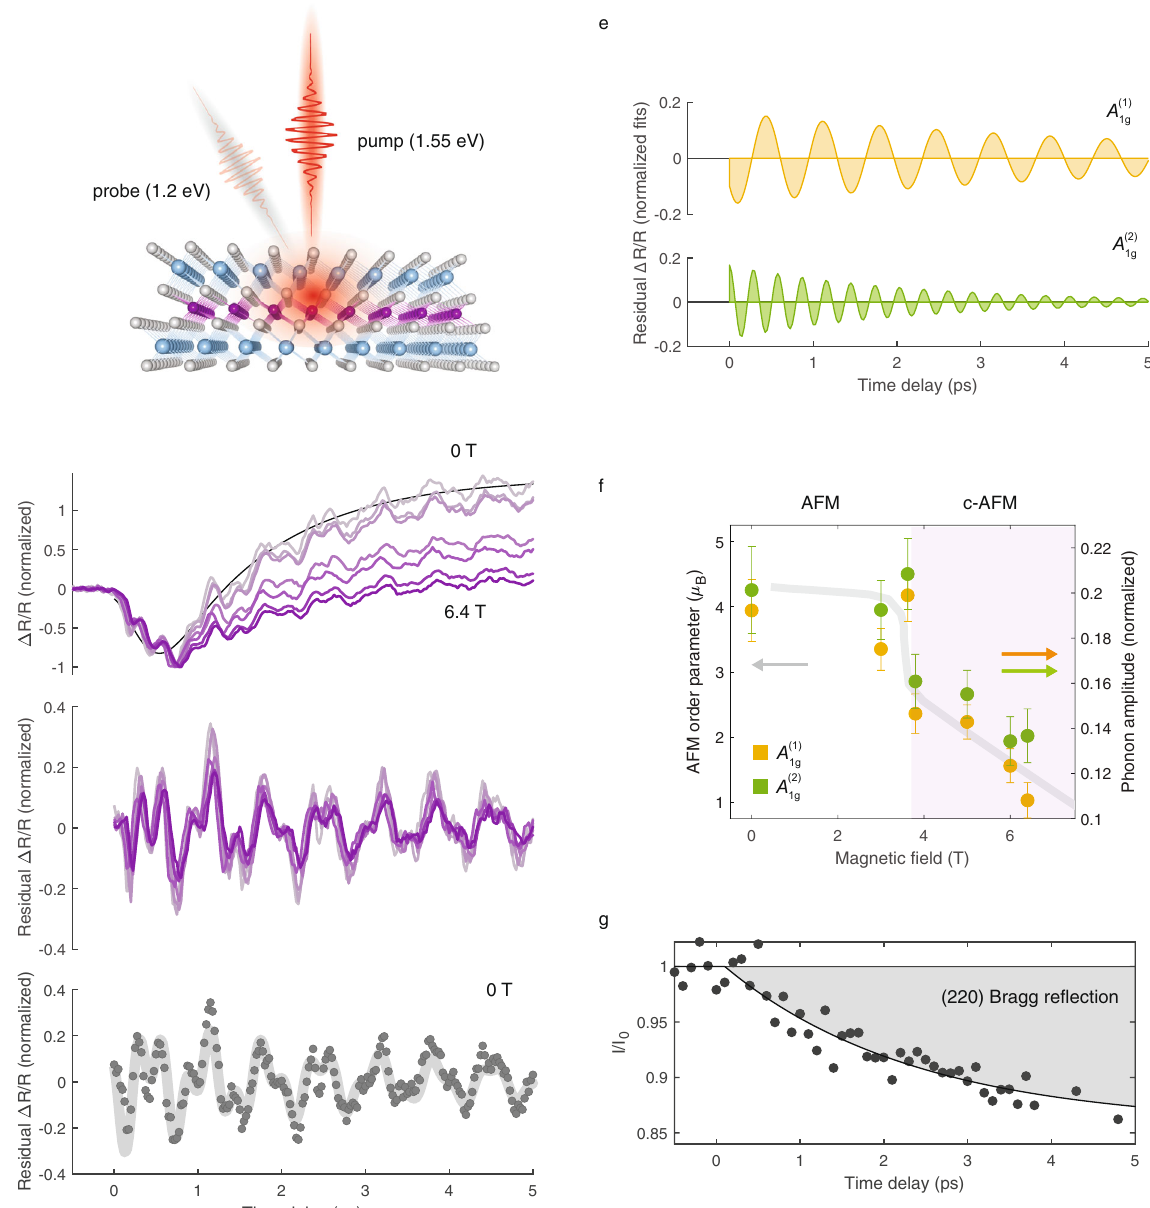
Fig. 4 Ultrafast signatures of magnetophononic coupling. a Schematic of pump-probe measurement. b Pump-induced changes in the transient re fl ectivity ( Δ R/R) as a function of time delay at various magnetic fi elds, normalized to the maximum amplitude. The black line is a representative biexponential fi t to the 0 T data. c The residual Δ R/R upon subtracting a biexponential fi t. d Residual Δ R/R at 0 T, with black dots denoting experimental datapoints and the gray line denoting the fi t to the sum of two decaying sinusoidal functions. e Individual decaying sinusoidal components obtained from the fi t in ( b ), corresponding to the A 1 g (1) (top) and A 1 g (2) (bottom) phonons, respectively. f Initial amplitude of the coherent A 1 g (1) and A 1 g (2) phonons, obtained from fi t result in ( d ). The gray line is the antiferromagnetic order parameter from reference 15 . g Measured transient electron diffraction intensity of the (2 2 0) Bragg peak, with black dots denoting experimental datapoints, and the black line denoting the fi t to an exponential decay function. Error bars are standard deviations in fi t